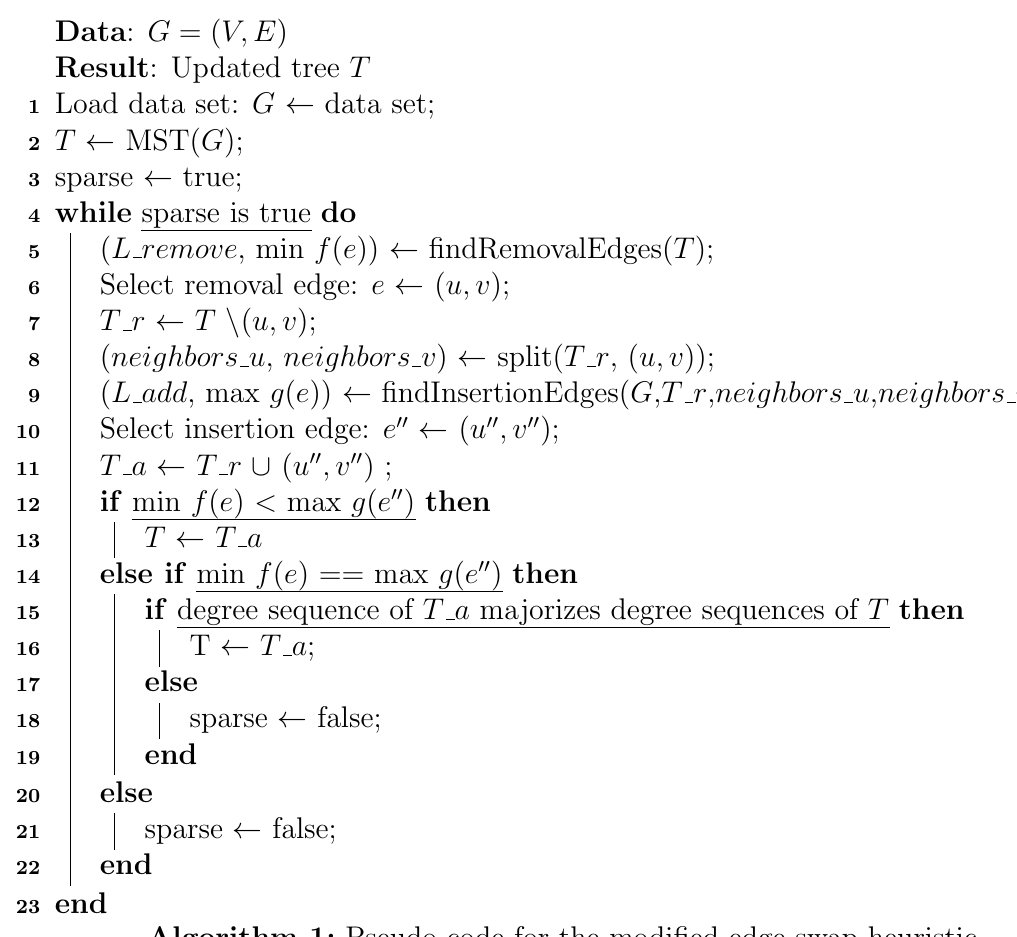
Algorithm 1: Pseudo-code for the modified edge-swap